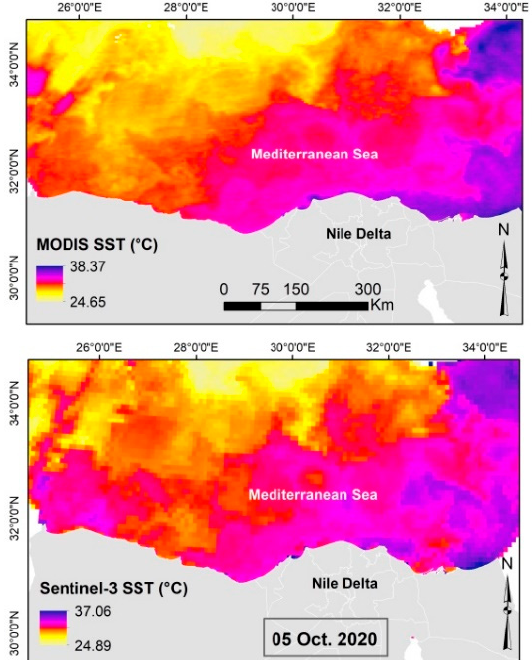
Figure 4. Example of changes in Sea-Surface Temperature on 5 October 2020 from both MODIS-Aqua and Sentinel-3 (an example of the data sources used).